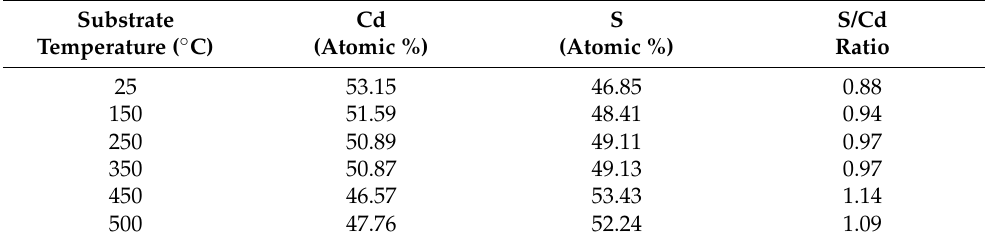
Table 2. Values of the variation in the chemical composition of CdS thin films grown at various substrate temperatures.